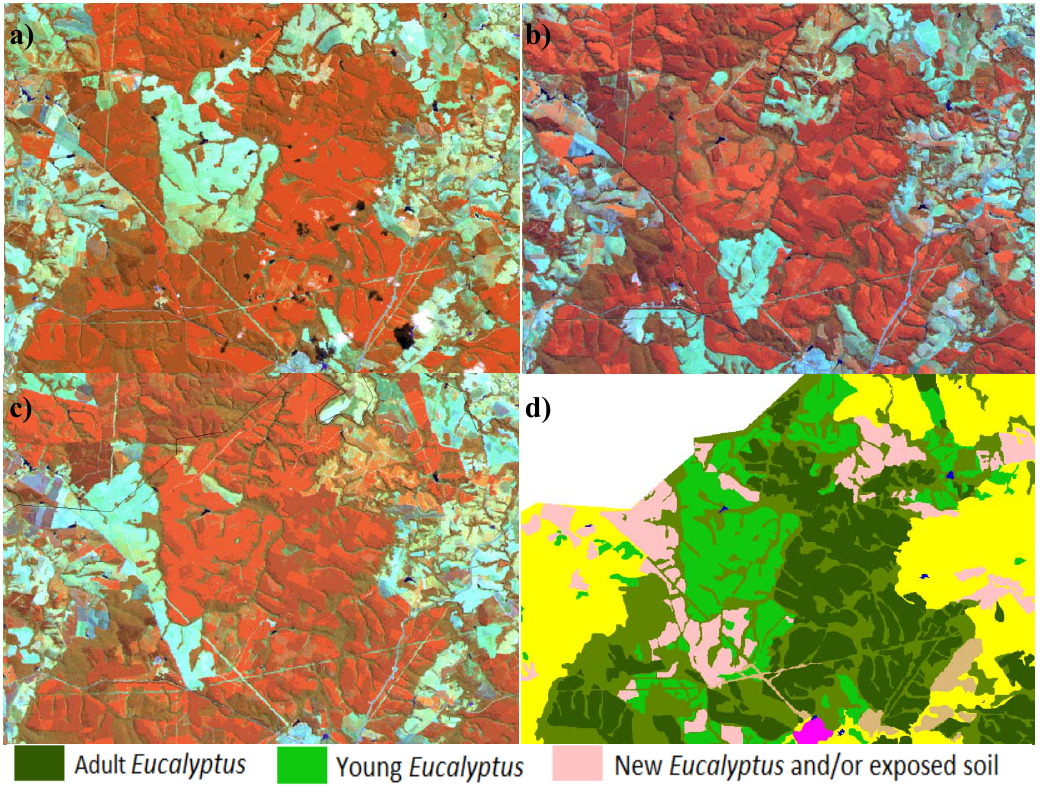
Figure 3. The different stages of the Eucalyptus cycle in remote sensing images. ( a ) Color composition RGB 543 year 2006; ( b ) year 2007; ( c ) year 2008; ( d ) cycles of Eucalyptus mapped.